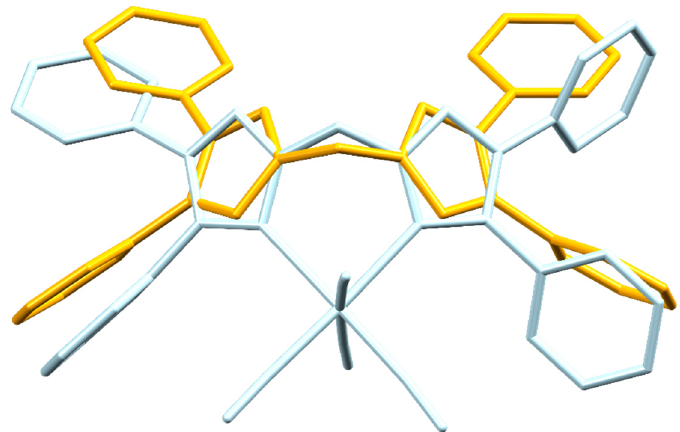
Figure 3. Structural overlay of the bistriazolium salt ( 2 ) and its corresponding bistriazolylidene complex ( 3 ). The counterion of ( 2 ) and the co-crystallized solvent of ( 3 ) are not shown for clarity reasons.